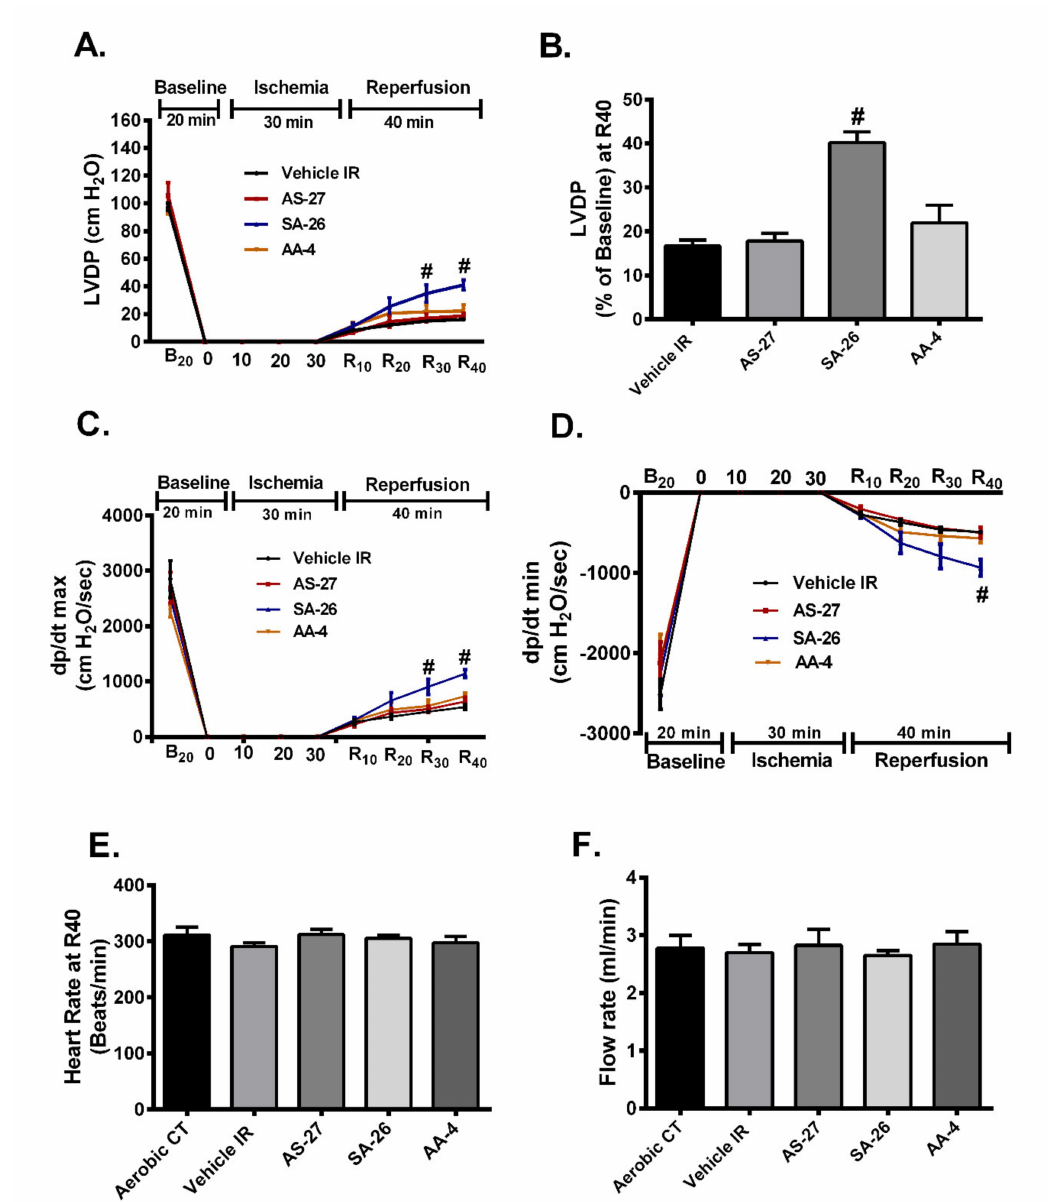
Figure 2. Perfusion of hearts with SA-26 improved postischemic contractile parameters. ( A ) LVDP at the baseline before drug treatment (B 20 ), during ischemia, and at 10, 20, 30 and 40 min reperfusion (R 10 , R 20 , R 30 , and R 40 ). ( B ) LVDP recovery at 40 min of reperfusion as a percentage of baseline. ( C ) Rate of contraction (dP / dt max), and ( D ) rate of relaxation (dP / dt min) at baseline before drug treatment (B 20 ), ischemia, and 10, 20, 30 and 40 min reperfusion (R 10 , R 20 , R 30 , and R 40 ). ( E ) Heart rate assessed as beats per minute (BPM) in vehicle treated aerobic hearts and hearts subjected to ischemia-reperfusion (IR) injury at the end of reperfusion (R 40 ). ( F ) Coronary flow rates from vehicle treated aerobic hearts as well as hearts subjected to IR injury assessed post-ischemia. Values represent mean ± SEM; # p < 0.05 vs. Vehicle IR ( n = 4–7 per group). LVDP; left ventricular developed